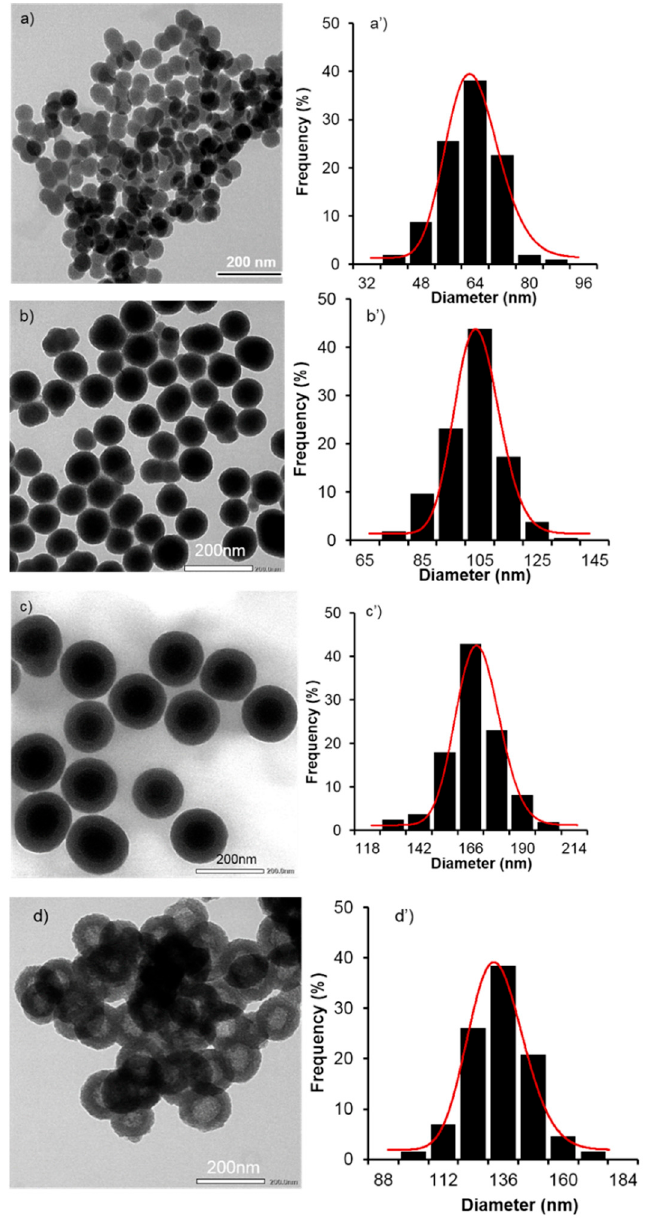
Figure 4. TEM images and the particle size distribution of PNS ( a , a’ ), sSiO 2 ( b , b’ ), sSiO 2 / SiO 2 / CTAB ( c , c’ ), and HMSN ( d , d’ ), respectively.